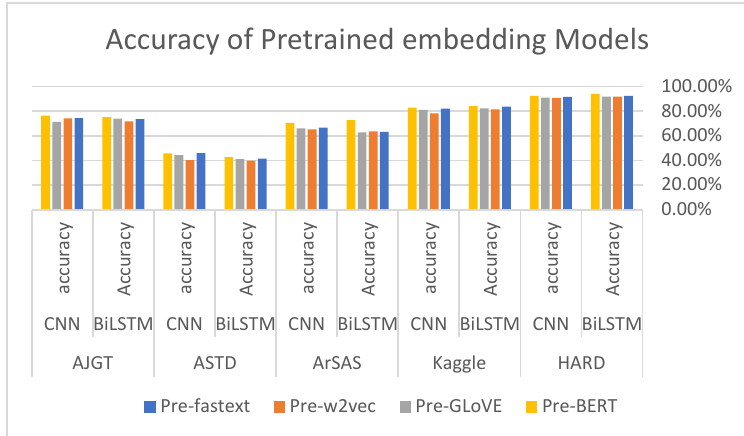
Figure 1. The accuracy of pretrained embedding. Table 5. Pretrained embeddings